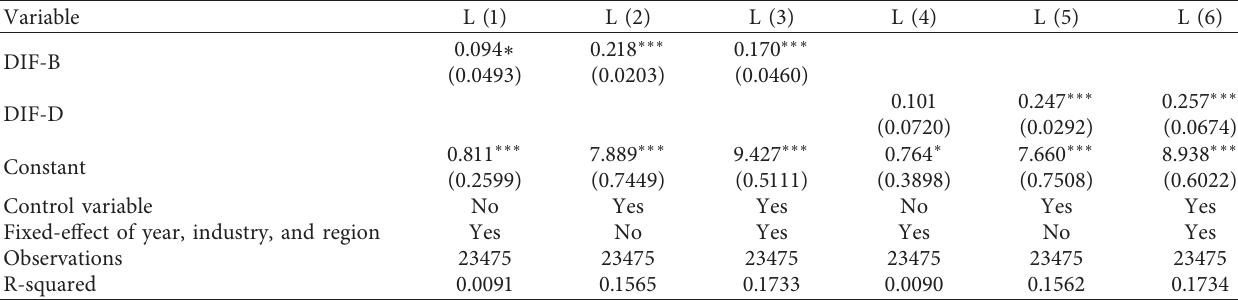
Table 4: The influence of subindexes of digital finance on enterprise financial